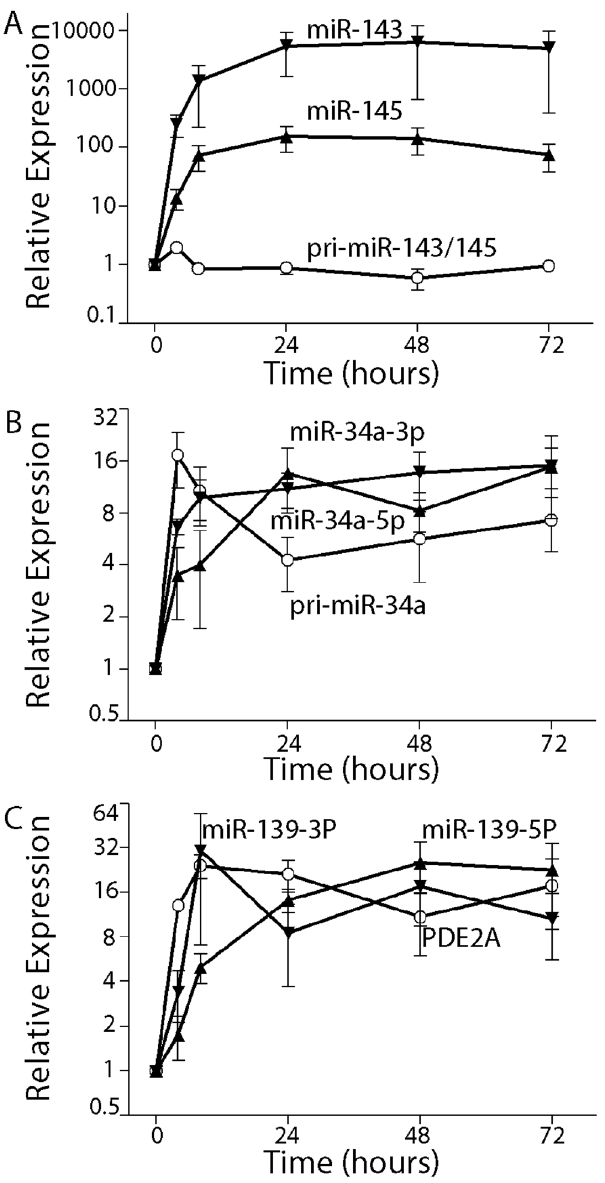
Fig 4. The induction of miRNAs and their respective pri-miRNA. The fold increase in RNA expression for the indicated miRNAs (closed symbols) and their respective pri-miRNAs (open symbols) is plotted as a function of time. Each point represents the mean ( ± SEM) determined from a minimum of 3 independent